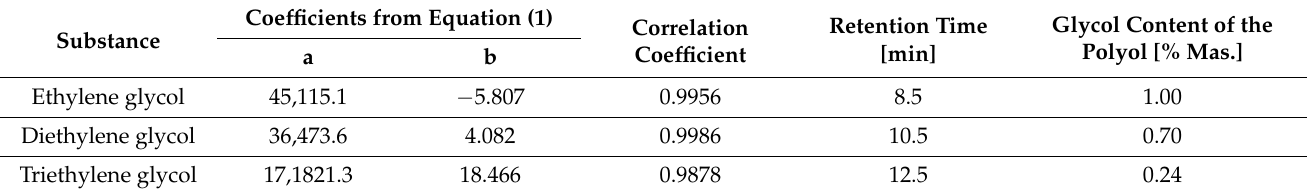
Table 2. Glycols used for the determination of the calibration curves and their content in the polyol. Coefficients from Equation (1) Correlation Substance